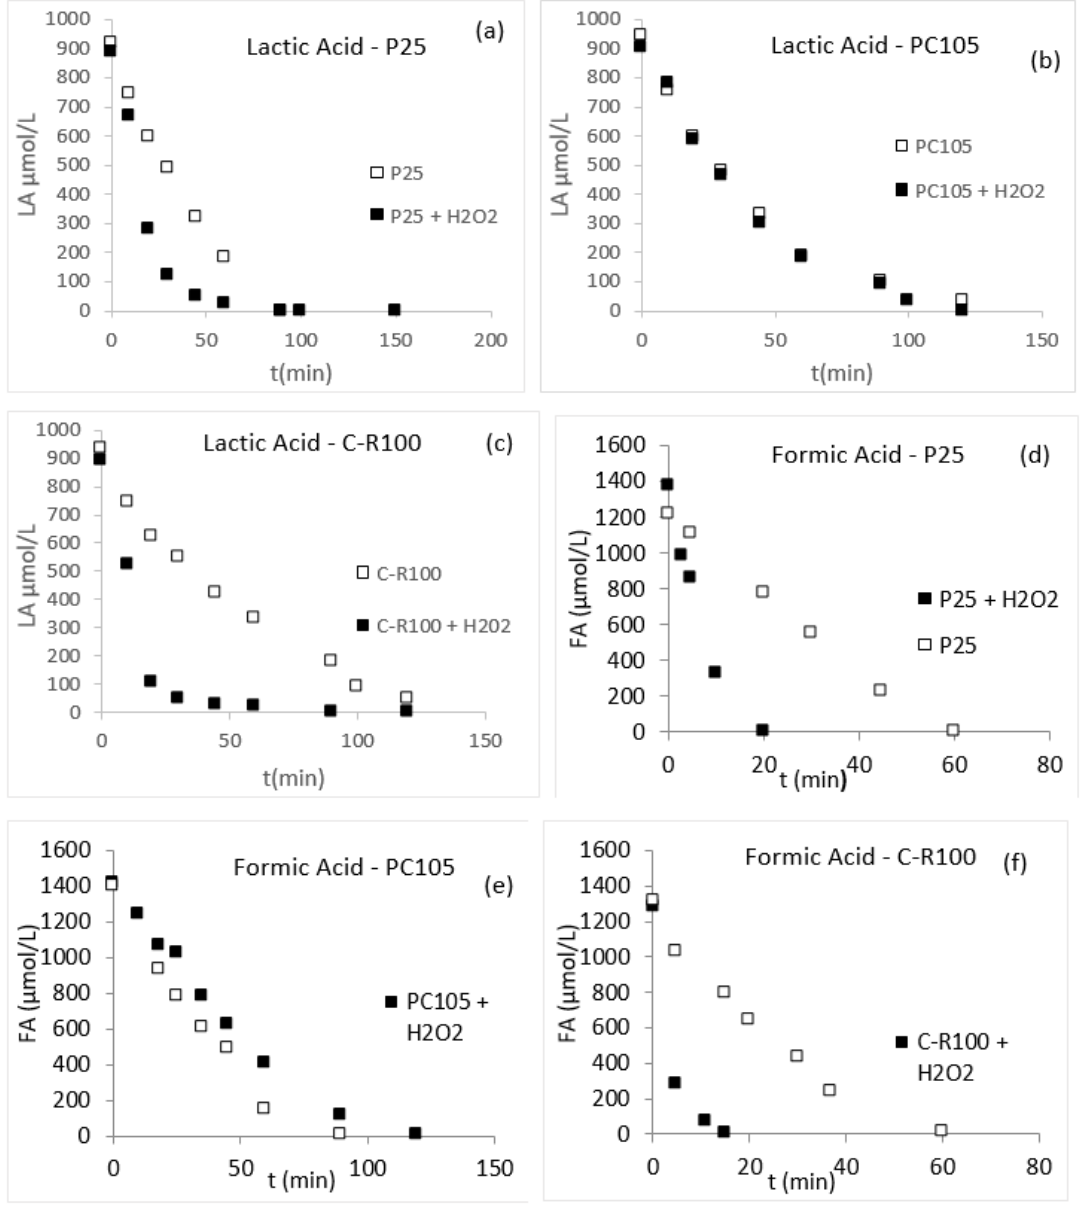
Figure 1. Degradation of lactic acid ( a – c ) and formic acid ( d – f ) in the presence of P-25, PC105 and C-R100, respectively.